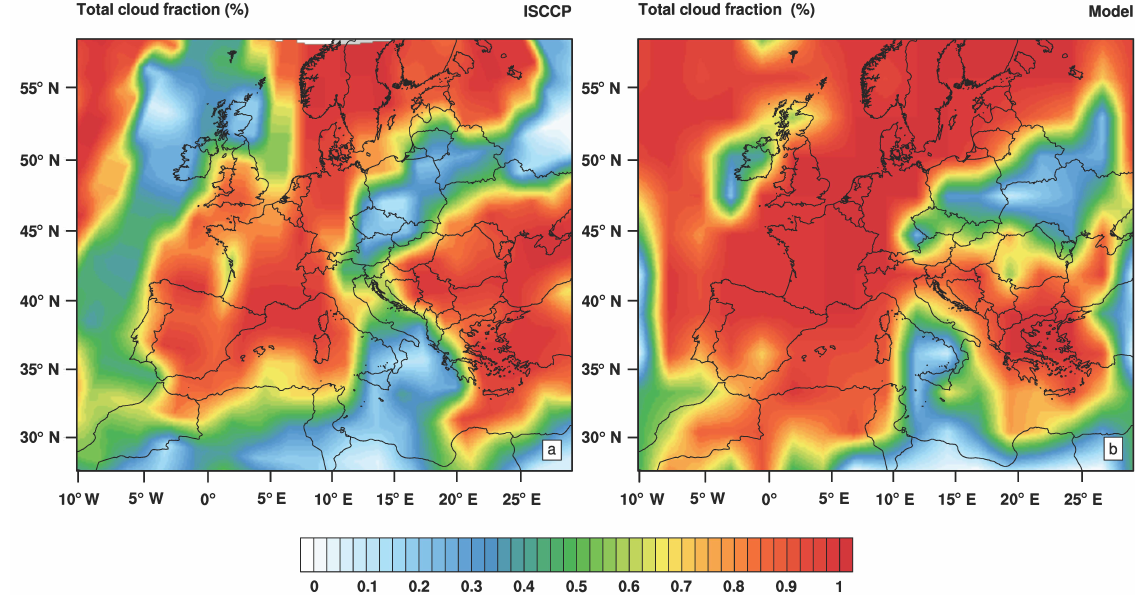
Figure 3. (a) Satellite and (b) model-derived (COSMO-MUSCAT) ISCCP cloud fraction for 17 February 2007 (averaged daily).